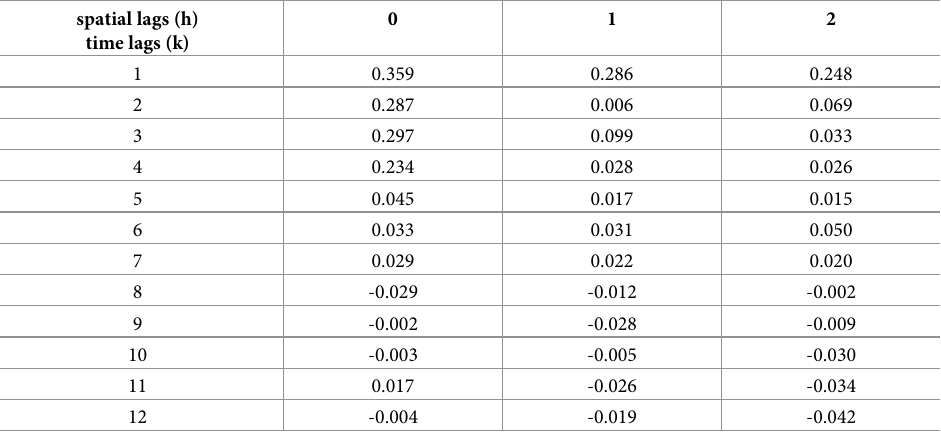
Table 7. ACF values of HFRS incidence after seasonal difference